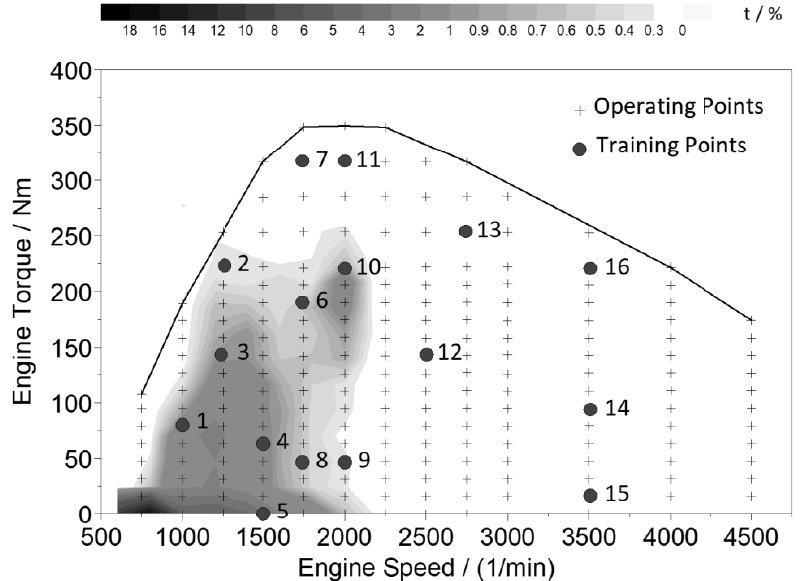
Figure 3. Selected (16) operating points depending on engine speed, brake torque, and timeshare in the cumulated dwell time (in %) in the reference RDE cycle for the combustion model calibration.